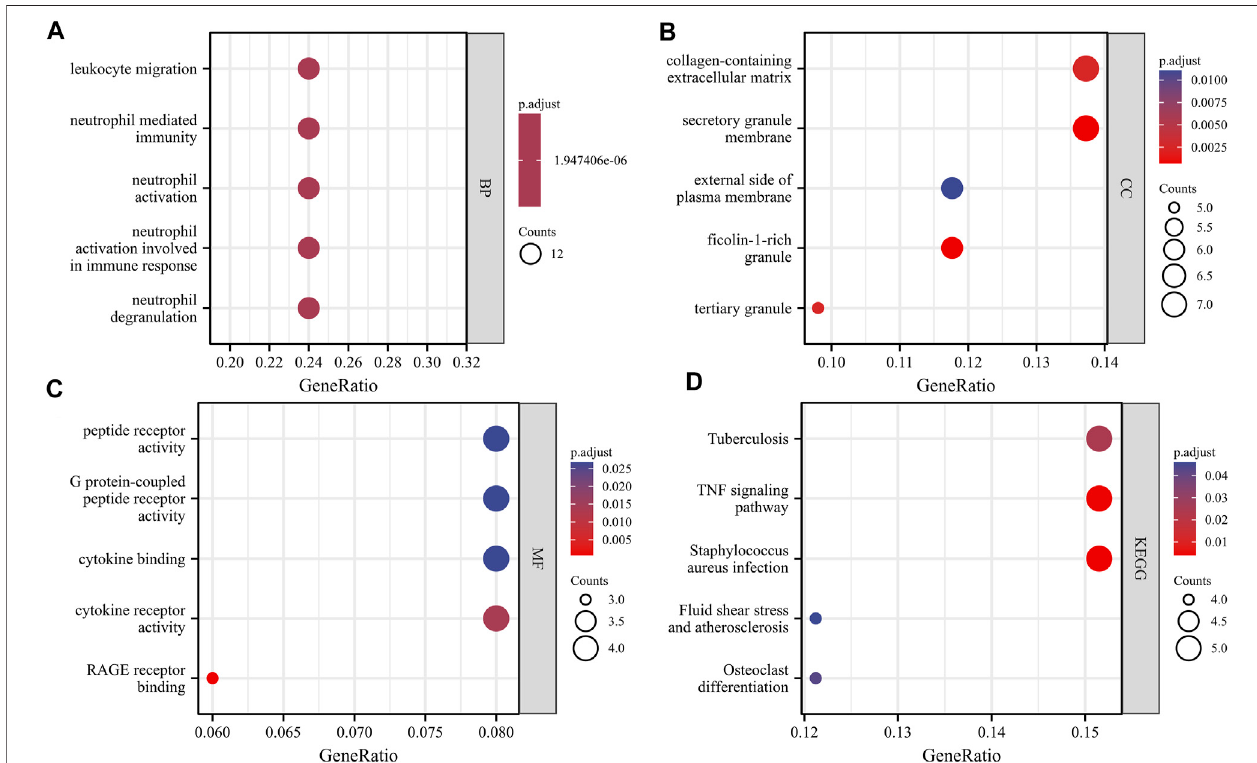
FIGURE 3 | GO and KEGG analysis results of overlapping DEGs. Panel (A) , GO biological process enrichment results; Panel (B) , GO cell component enrichment results. Panel (C ), GO molecular function enrichment results. Panel (D) , KEGG pathway enrichment results. An adjusted p < 0.05 wasidenti fi ed as signi fi cantly changed GOsandKEGG.The x -axisshowsthegeneratioofeachterm.The y -axisrepresentstheannotationitemsofGO-BPinA,theannotationofGO-CCinB,theannotationof GO-MFinC,andtheannotationofKEGGinD.Thebubblesizerepresentsthenumberofgenesassociatedwitheachterm.Thecolorofeachbubblerepresentsthe adjusted p value: the redder the color, the higher the enrichment. Abbreviations: GO, Gene Ontology; BP, biological process; CC, cellular component; MF, molecular function; KEGG, Kyoto Encyclopedia of Genes and